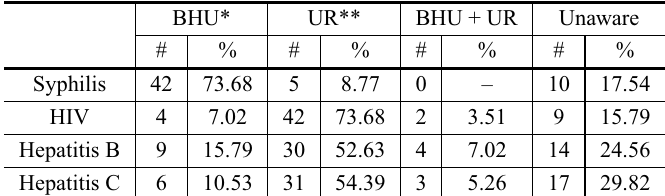
Answers from 57 health professionals concerning places to attend pregnant women with infectious diseases susceptible